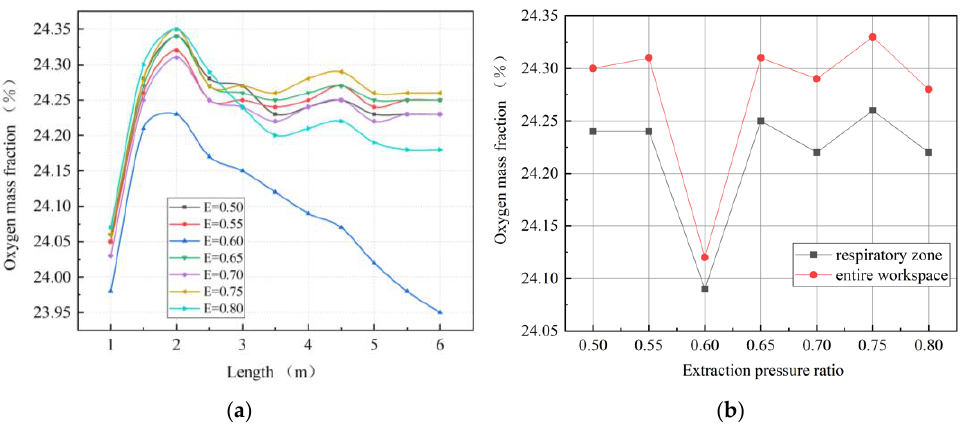
Figure 16. Characteristic diagrams of oxygen mass fraction distributions in the main working area. ( a ) Oxygen mass fractions along the roadway; ( b ) oxygen mass fractions in the respiratory zone and in the entire workspace.